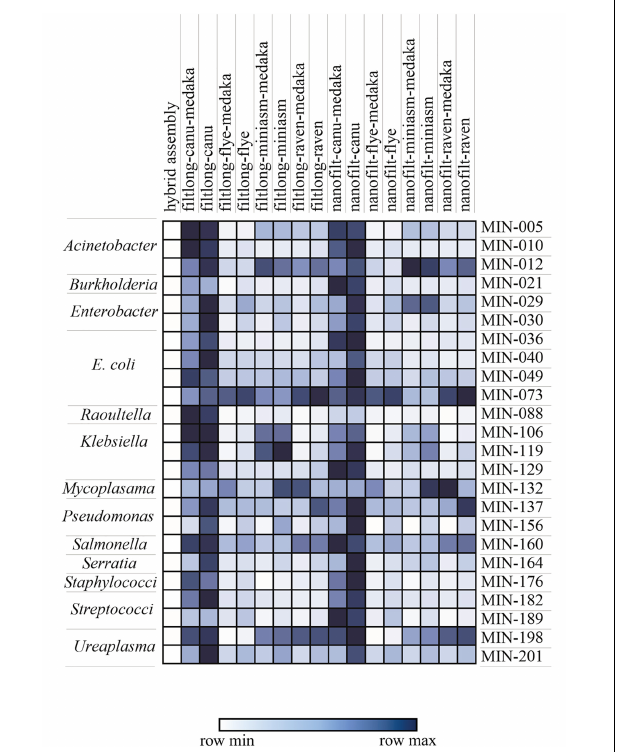
FIGURE 5 | Mash distance matrix comparing the hybrid assembly to each long-read only assembly variation for n = 23 isolates (MIN-, only isolates where all assemblies were generated were included). The darker (blue) represents a greater genomic distance. The species/genera are indicated on the left.